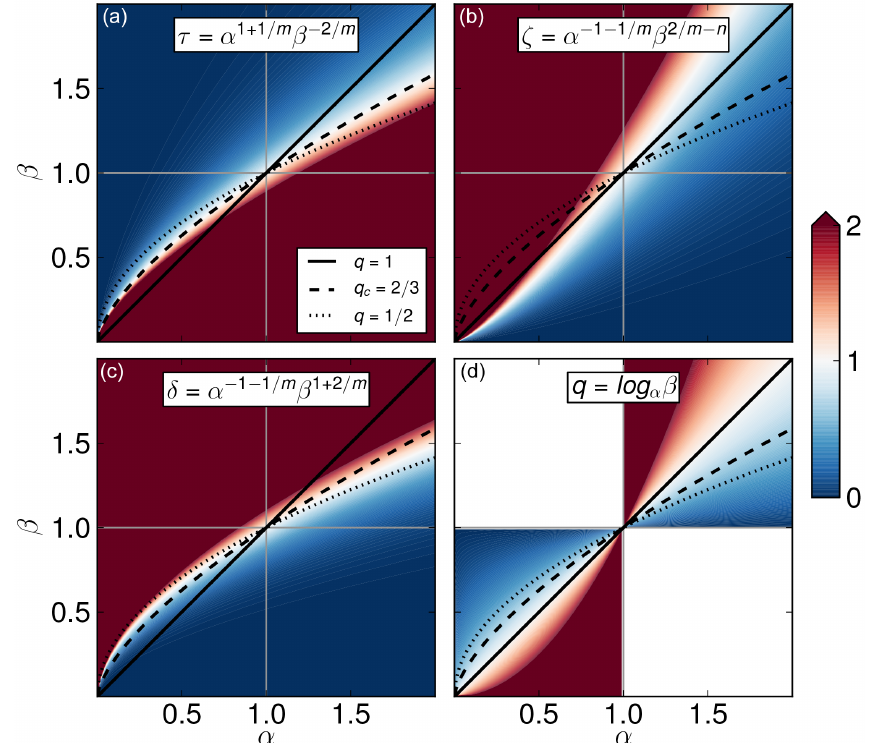
Figure 7. Scaling of (a) response time (Eq. 11), (b) ice softness (Eq. 16) and (c) surface mass balance (Eq. 15) in the α - β phase space for γ = 1 and m = 1 / 3. Panel (d) shows value of the exponent q when the two horizontal scales are linked according to Eq. (25). Dotted line represents scaling of an ice sheet with Vialov proportions. Dashed line denotes critical threshold τ = 1.